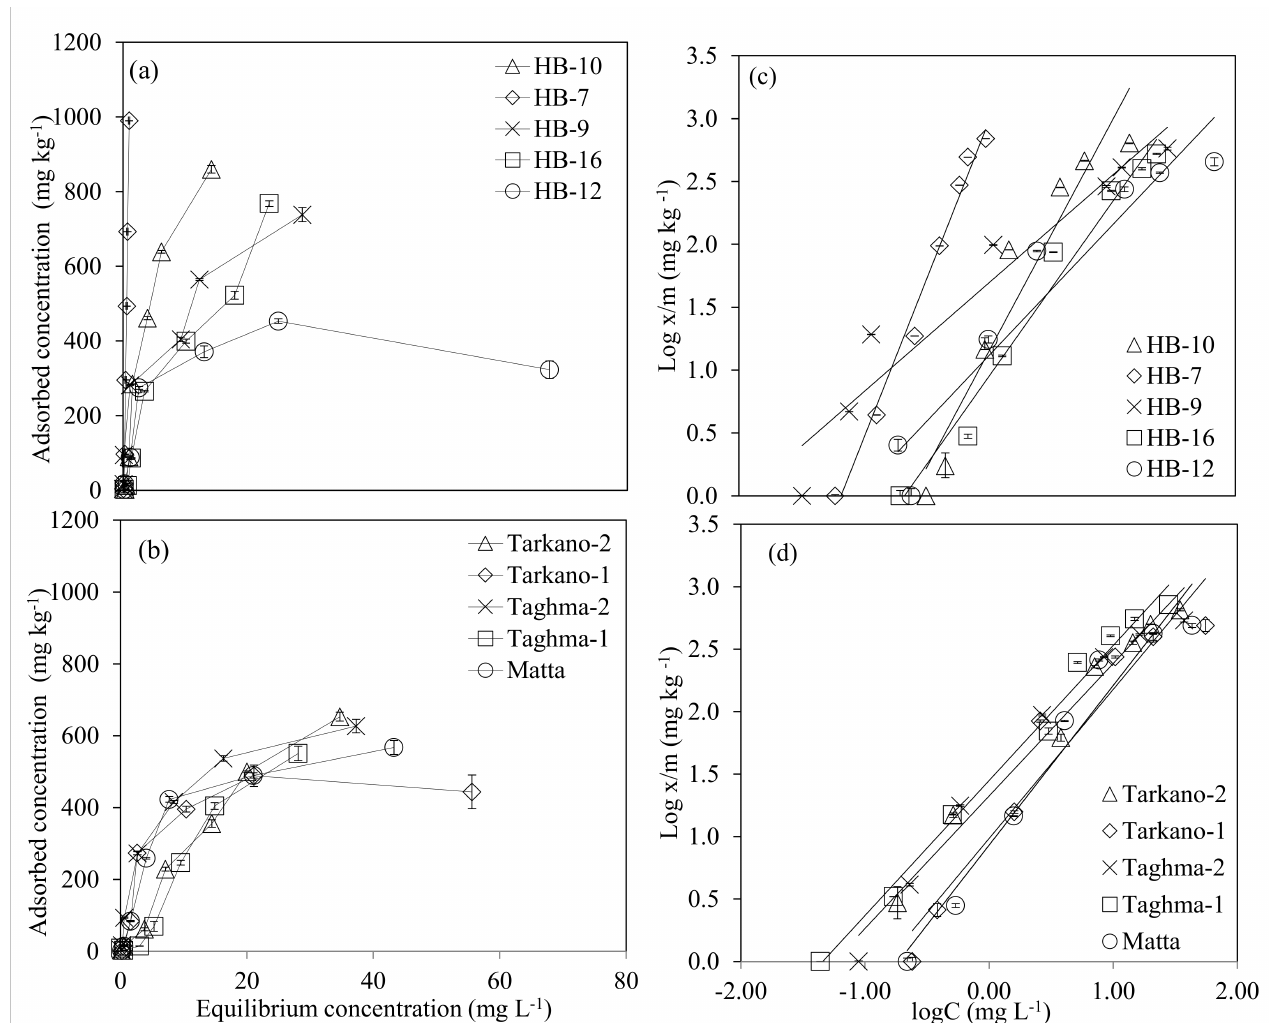
Figure 2. Adsorption isotherms of ( a ) laterite and ( b ) kaolinite, ( c , d ) depicts the Freundlich Equa- tion (4) fit for As in the laterite and kaolinite, respectively. The trend line equation was solved to get adsorption parameters. Error bars indicate the standard deviation among replicates ( n =